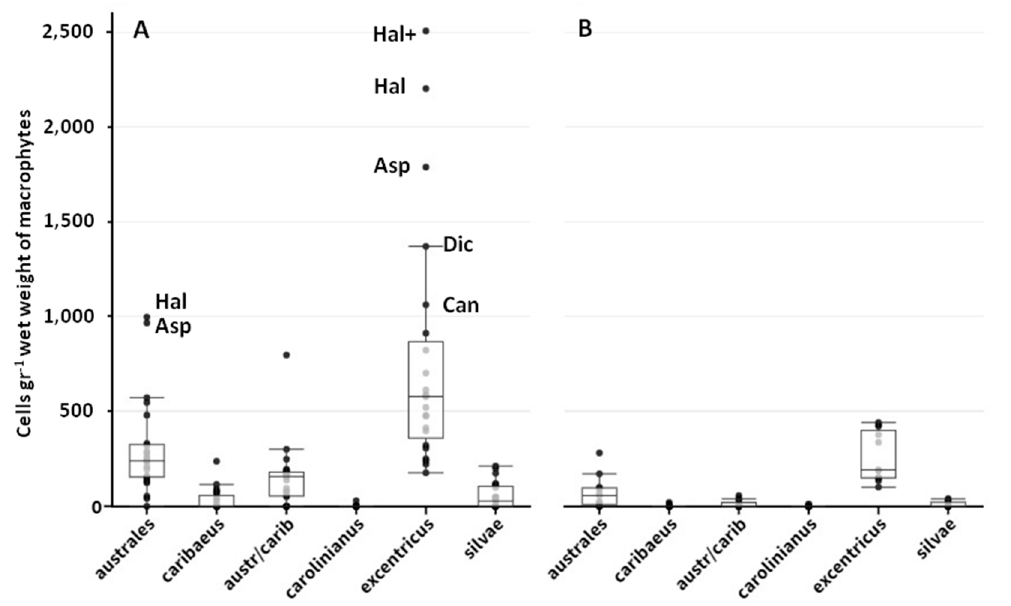
Figure 7. Box plot of cell abundances of Gambierdiscus species in Cotillo ( A ) and Playitas ( B ) stations in Fuerteventura Island. The macrophyte species that presented concentrations of Gambierdiscus close to 10 3 cells gr − 1 are indicated (see macrophyte codes in Table 1).